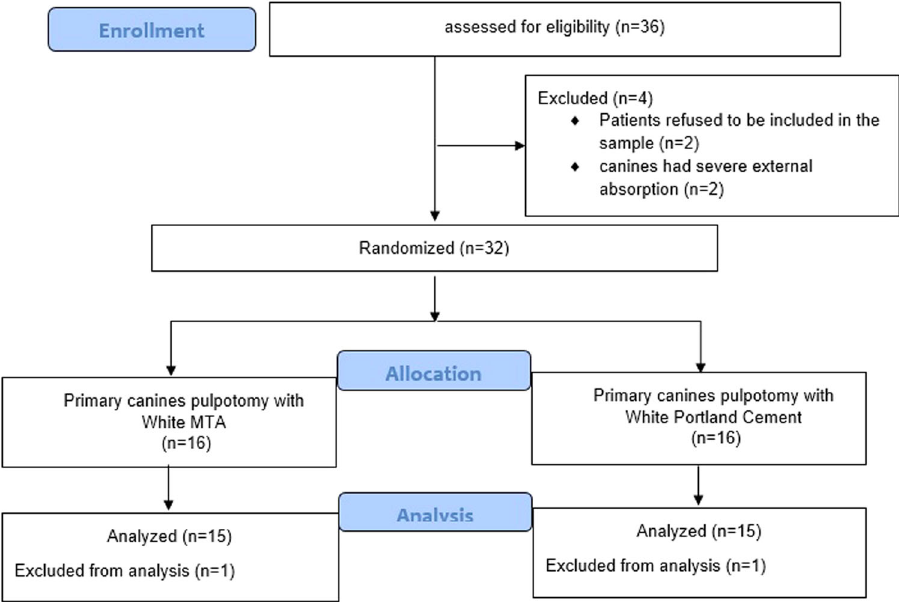
Fig. 1 CONSORT fl ow